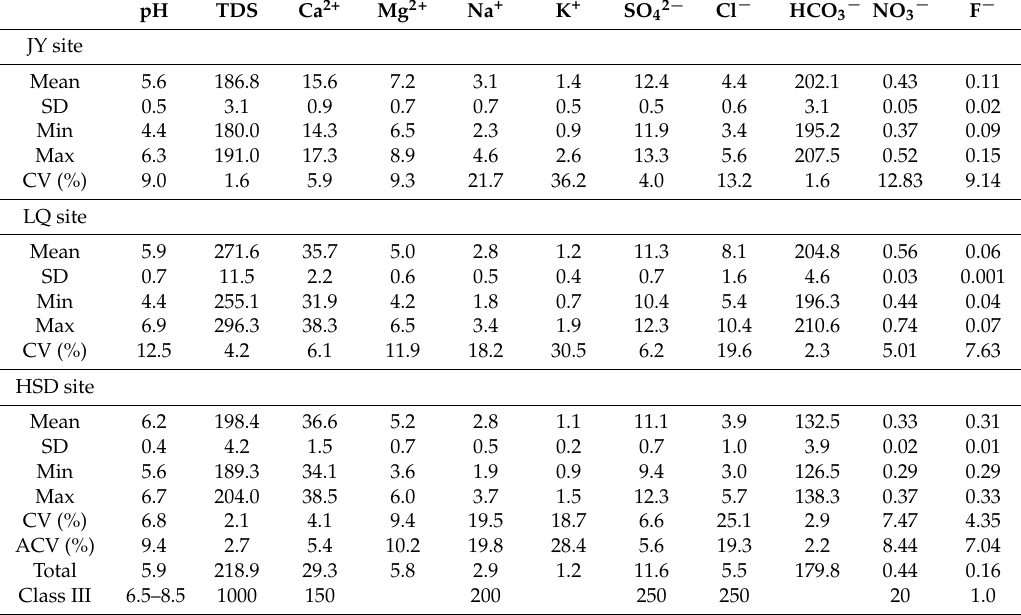
Table 3. Descriptive statistics of hydrochemical parameters concentrations (mg L − 1 ) in groundwater of turfy